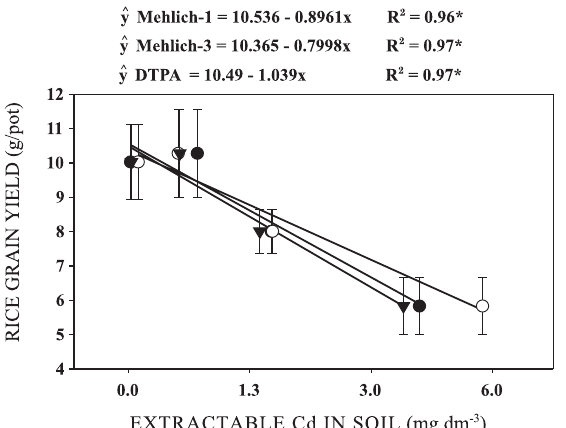
Figure 2. Correlation between rice grain yield and soil available Cd extracted with Mehlich-1( ), Mehlich-3( ) and DTPA ( ). *Significant at p <